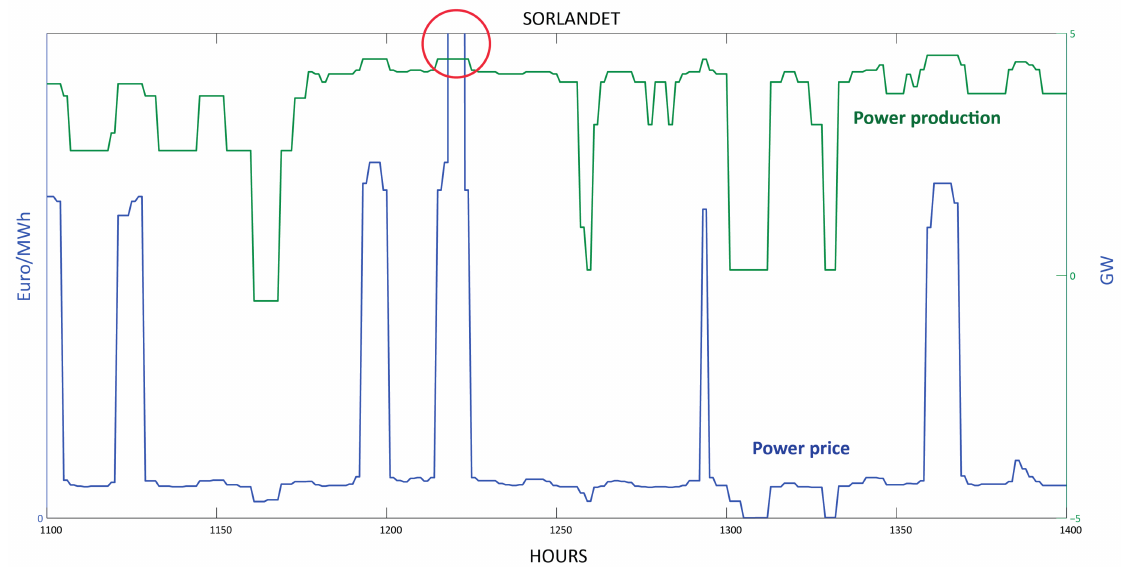
Figure 8. Price ( blue curve ) versus hydropower production ( green curve ) SORLANDET (11 GW extra capacity case) year 38, hour 1100 to